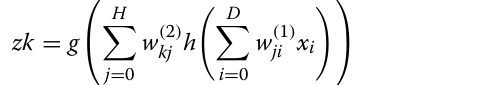
information for understanding the variation in texture pattern due to the type of leather defects on folding marks, grain off, pinhole, growth marks, and loose grain. Grey Level Co-occurrence Matrix (GLCM) for the given leather image is constructed by counting all pairs of a ref- erence and neighbouring pixel separated by an offset (d) having the gray levels i and j at the specified relative